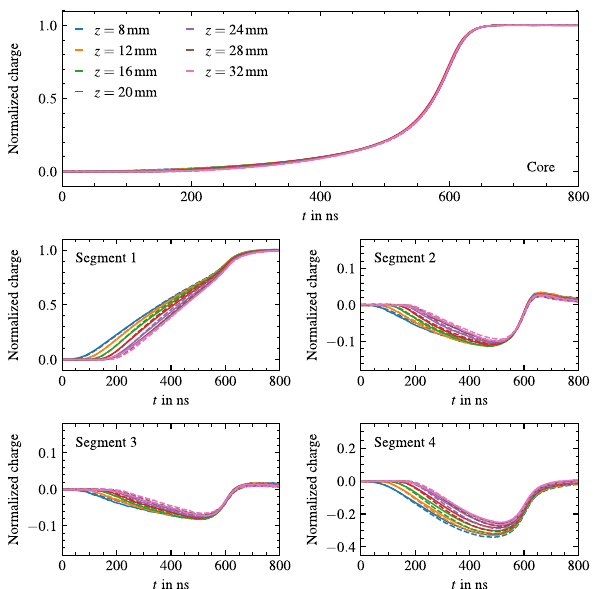
Fig. 15 Superpulses of events assigned to interaction points on the (cid:4) 100 (cid:5) axis in segment 1 of the segBEGe detector for different z as given in the legend at a detector temperature of 78K. The solid lines depict superpulses from a Compton Scanner measurement at φ = 46 . 1 ◦ and r = 35 . 5mm. The dashed lines depict ( 81 ± 2 ) keV superpulses from 133 Ba measurements at φ = 47 . 2 ◦ . All pulses are time-shifted such